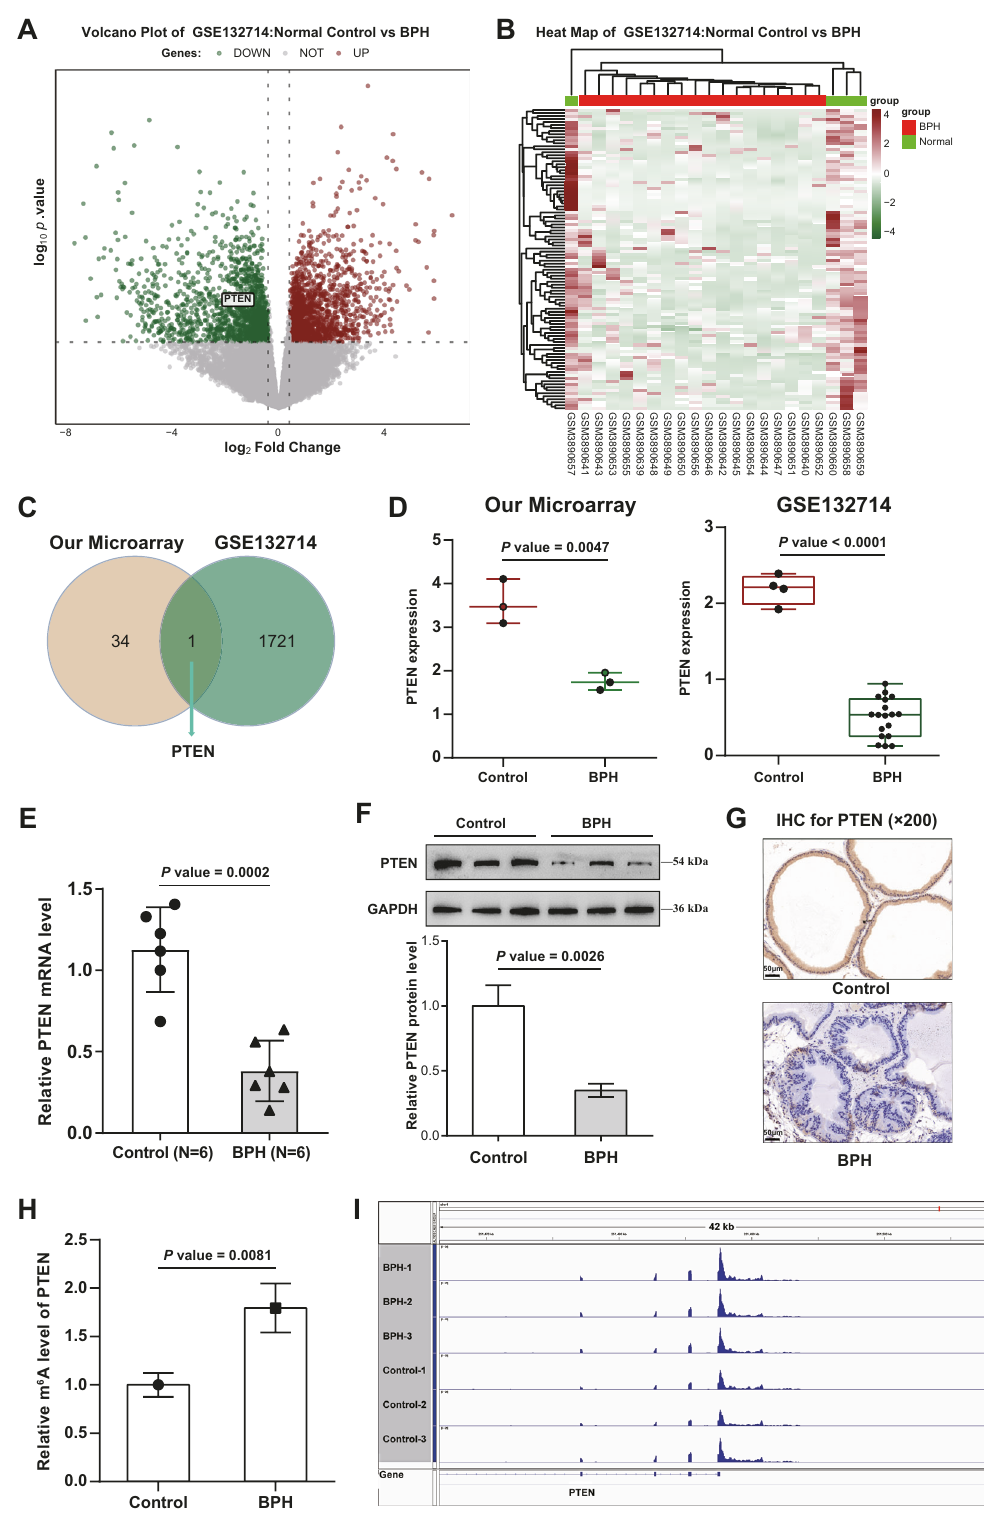
Fig. 4 PTEN is highly m6A-modi fi ed and downregulated in BPH. A , B The expression pro fi le between control and BPH samples was analyzed using the R language LIMMA package based on GSE132714. C Genes with altered m 6 A modi fi cation status and altered expression levels were compared, and PTEN was selected. D PTEN expression in normal control and BPH samples according to our microarray and GSE132714. E the mRNA level of PTEN in normal control and BPH samples were determined using RT-PCR. F , G PTEN protein levels in normal control and BPH samples were determined using Immunoblotting and IHC staining. H The m 6 A modi fi cation status of PTEN in normal control and BPH samples was determined using an m 6 A RNA Methylation Assay Kit. I The m 6 A modi fi cation status in PTEN 3 ′ UTR was analyzed using IGV